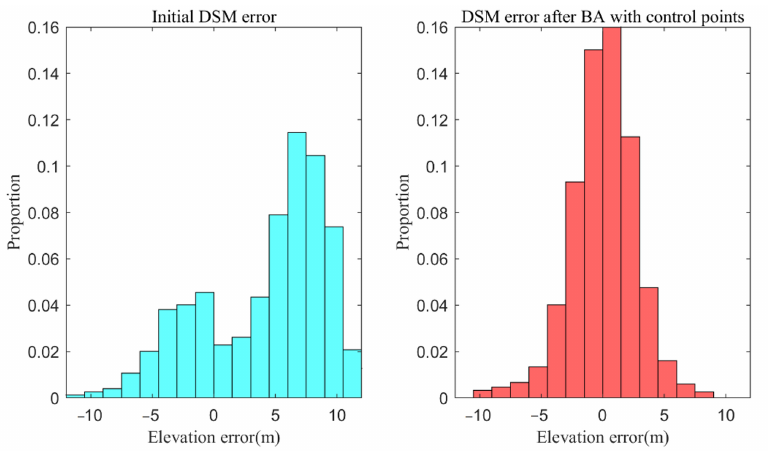
Figure 7. Elevation accuracy of the check points before and after block adjustment for the SRTM and ZY-3 DSMs.